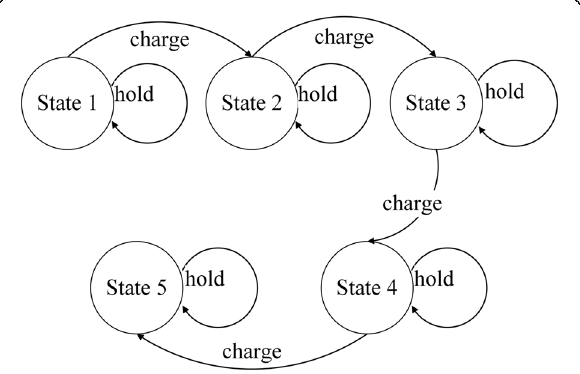
Fig. 2 State flow chart for EV